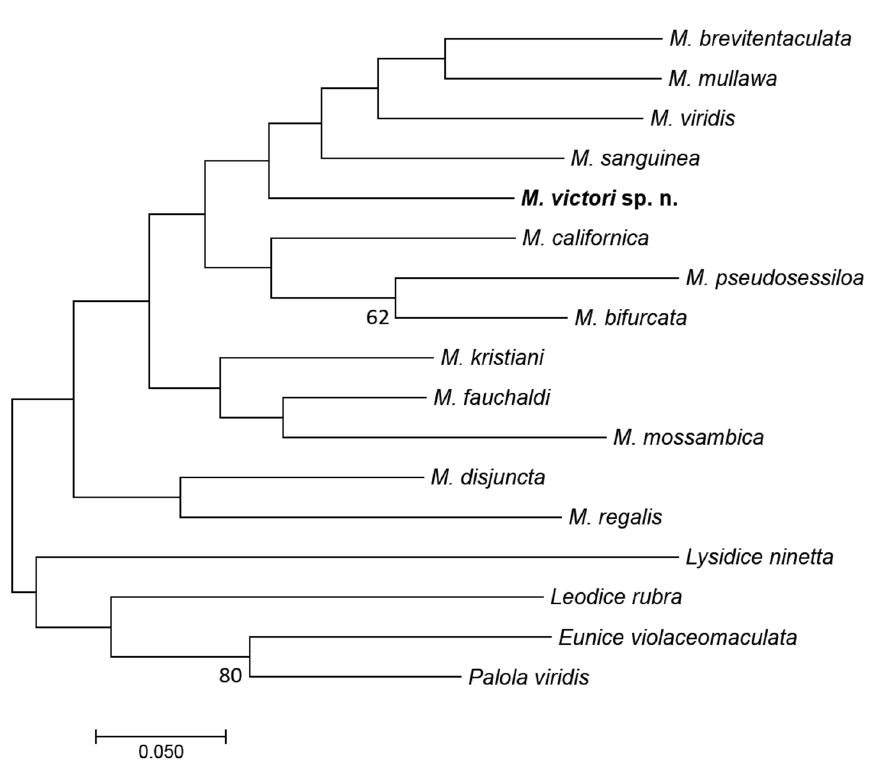
Figure 5. Maximum likelihood tree based on cytochrome oxidase I (COI) sequences and Kimura-2-pa- rameters model. Bootstrap values on nodes if